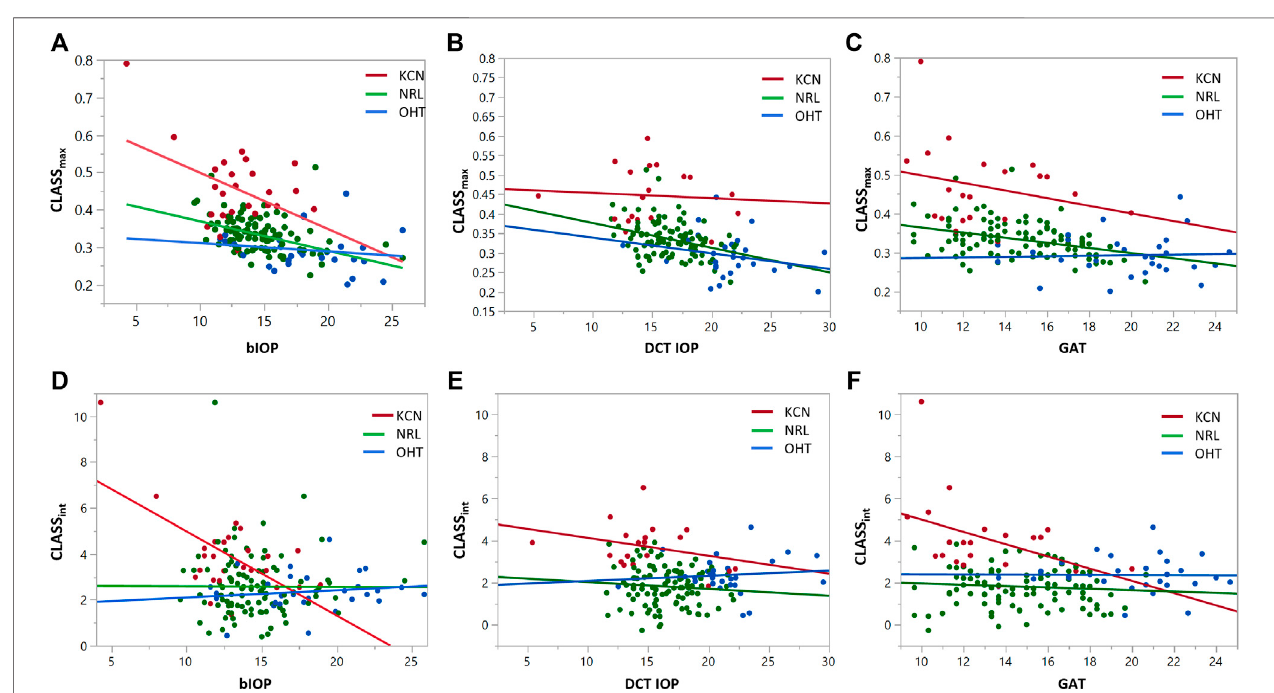
FIGURE 4 | Regression analysis for CLASS max and CLASS int with respect to bIOP (A,D) , DCT IOP (B,E) and GAT (C and F) , for keratoconic (KCN), normal (NRL), and ocular hypertensive (OHT) subjects.